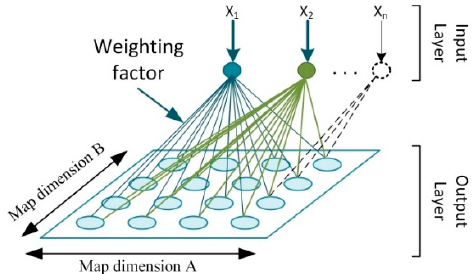
Figure 2. Schematic diagram of the Kohonen network.